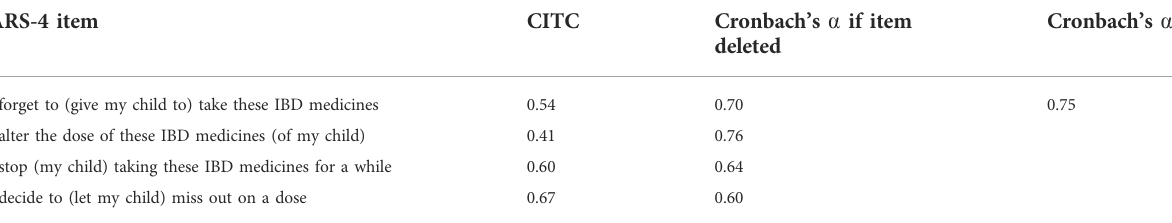
TABLE 2 Reliability test of MARS-4 ( n =